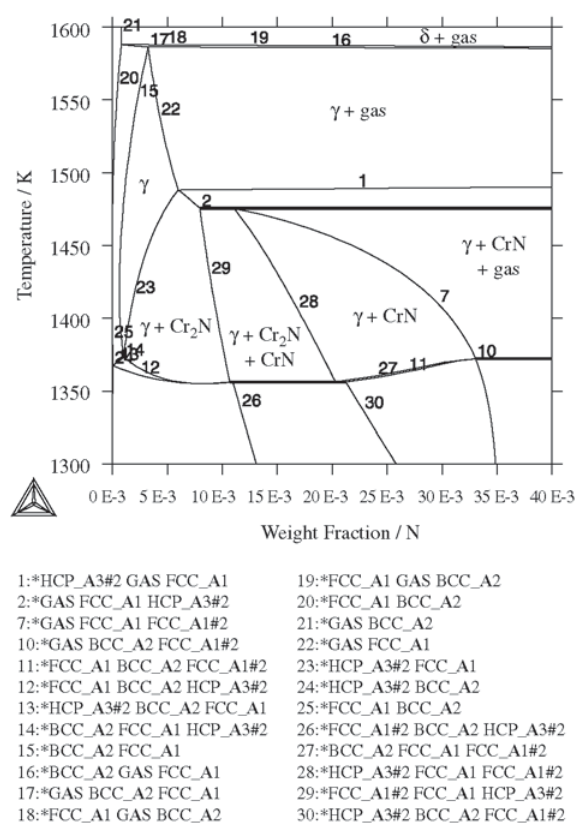
Figure 3. Isopleth of the Fe- 13% Cr – N system for 0.25 MPa N 2